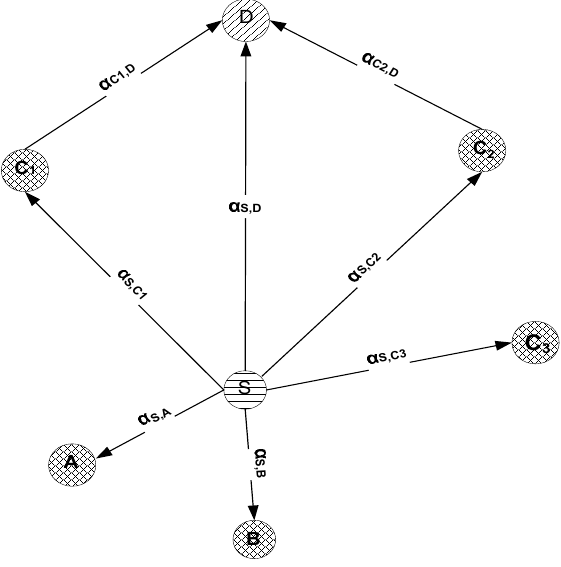
Figure 5. Cooperative diversity